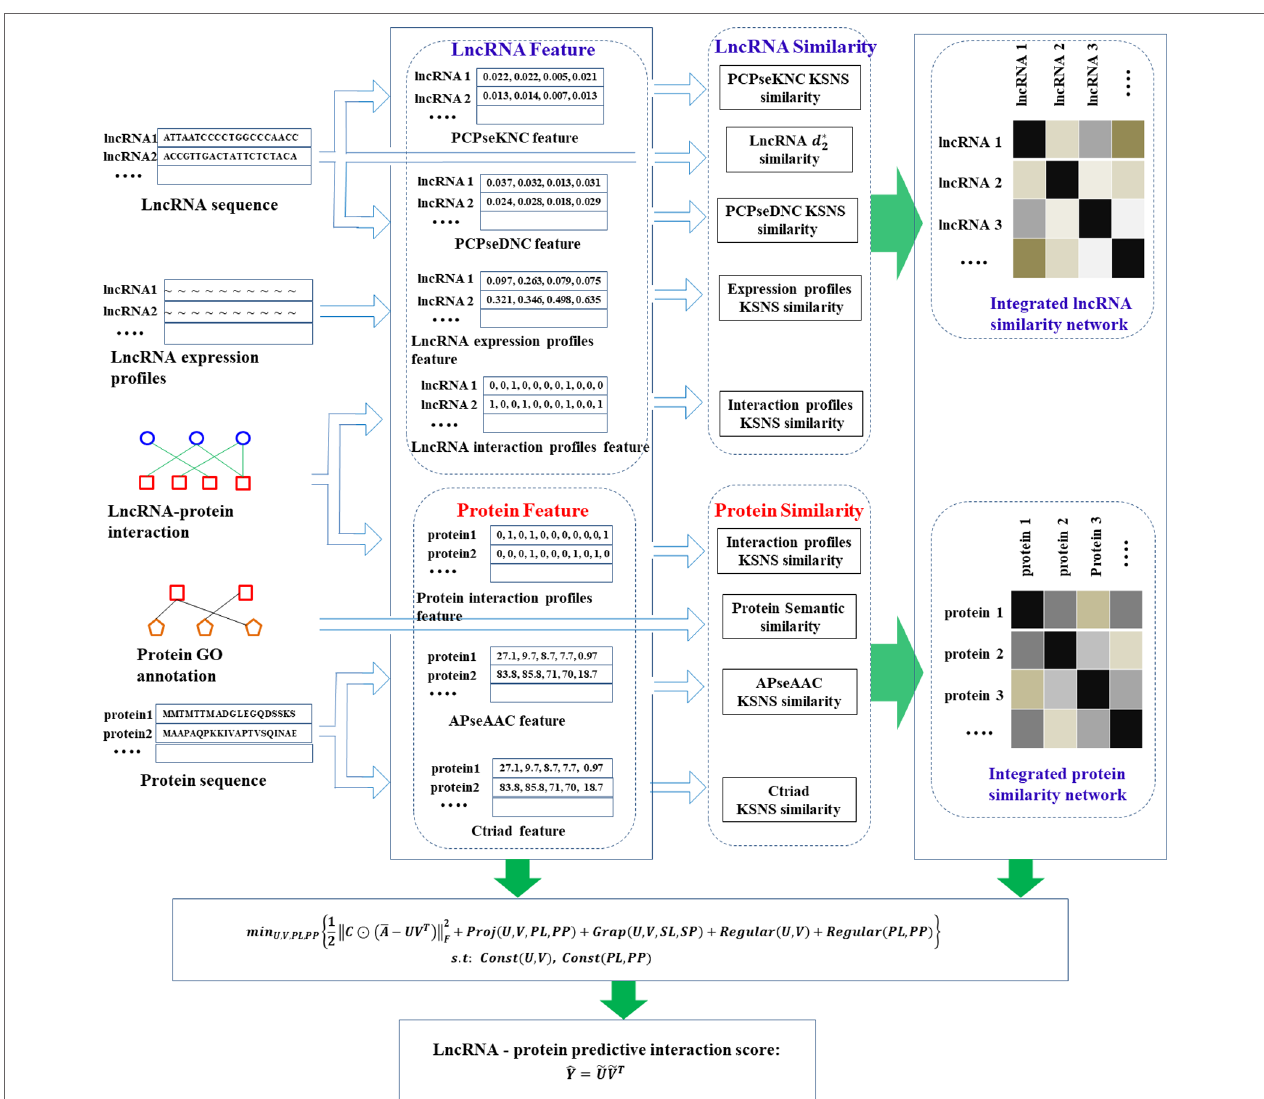
FIGURe 1 | Flow chart of lncRNA-protein interaction prediction by PMDKN algorithm. As shown in the figure, we first calculated three features of lncRNAs and two features of proteins, and then calculated five similarities of lncRNAs and four similarities of proteins according to lncRNA sequence, protein GO annotation and their